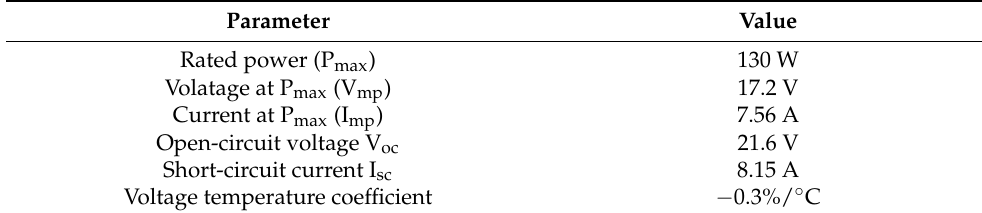
Table 1. PV panel Table 1. PV panel specifications.